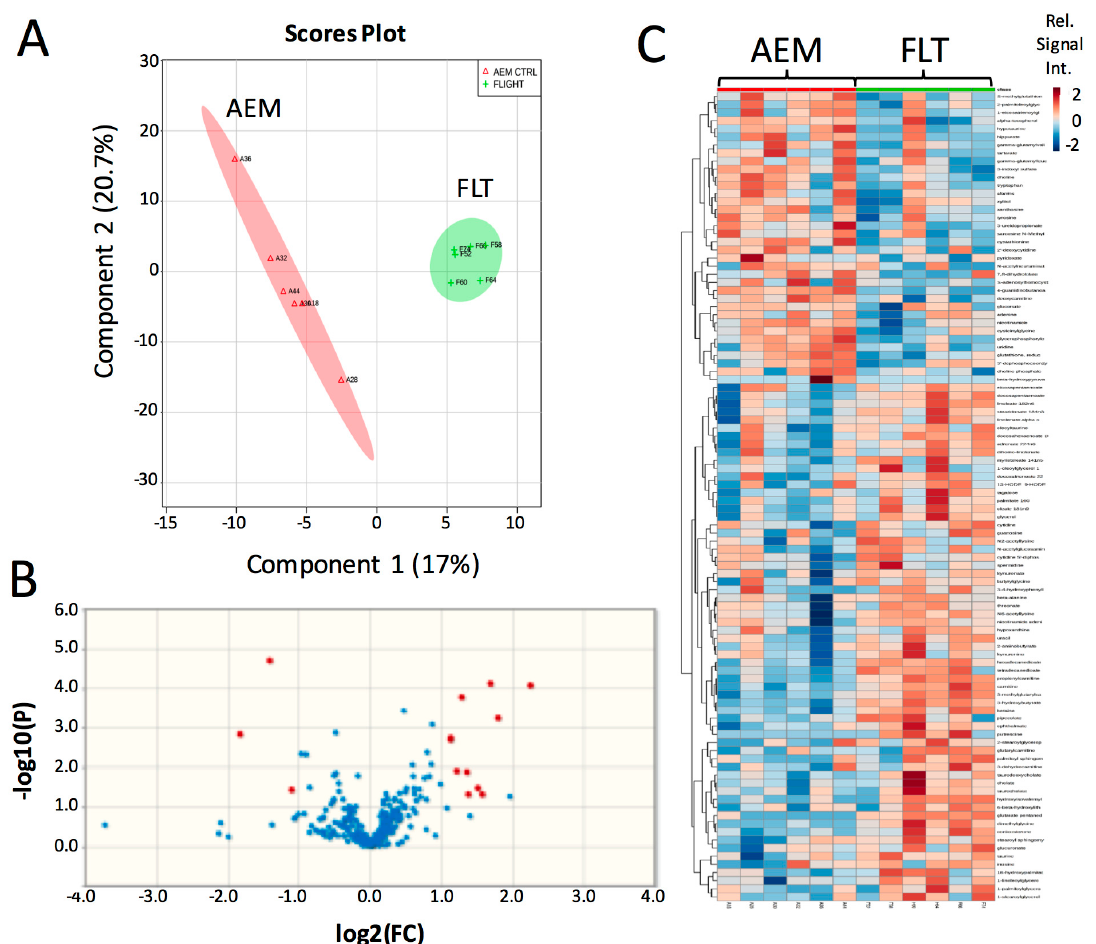
Figure 1. Brief exposure to the space environment results in significant metabolite changes in mouse liver. ( A ) PLS-DA analysis was performed on normalized metabolomics data that was subsequently log-transformed and auto-scaled. The first two components are plotted; ( B ) volcano plot comparing flown in space (FLT) vs. matched ground controls (AEM) considering unequal variance and using a fold change (FC) threshold of 2 and a p (corr) -value threshold of 0.05. Data points in red indicate significant named biochemical features. Data points in blue are not significant; ( C ) heat map and hierarchical clustering performed using a Pearson score for the distance measure, with features organized by VIP score from the PLS-DA analysis. Red—AEM, green—FLT; red indicates compounds with high signal abundance and blue those with low signal abundance. Color intensity correlates with relative signal abundance. n = 6/group. Table 1. Significantly changing biochemicals in spaceflight identified in volcano plot analysis.